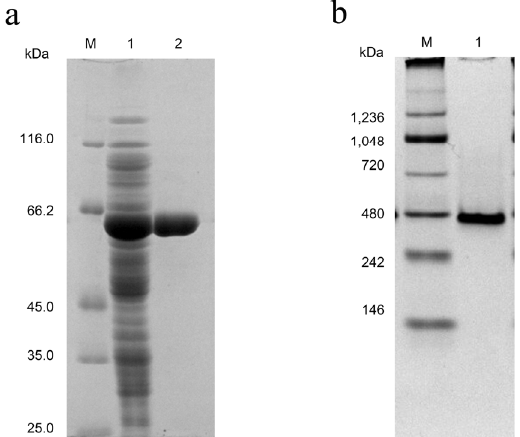
Figure 4. SDS-PAGE ( a ) and Native-PAGE ( b ) analysis of the purified proteins: ( a ) Lane M, molecular size marker (Unstained Protein Molecular Weight Marker: 116, 66.2, 45, 35, 25 kDa); lane 1, crude enzyme; lane 2, purified MpTre15A after Ni-IDA column; ( b ) Lane M, molecular size marker (Unstained Protein Molecular Weight Marker: 1234, 1048, 720, 480, 242, 146 kDa); lane 1, purified MpTre15A.